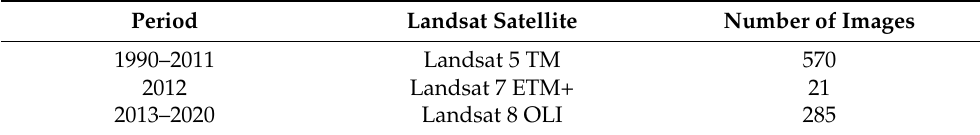
Table 1. Landsat image data for the study area used in this study. Period Landsat Satellite Number of Images